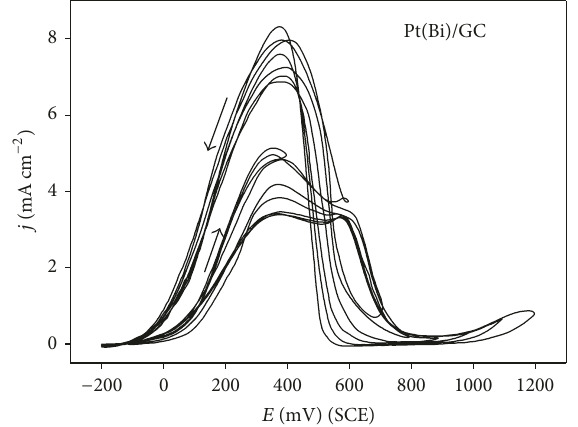
Figure 5: CVs for oxidation of 0.125 M HCOOH in 0.1M H 2 SO 4 on Pt(Bi)/GC electrode at 50mVs – 1 and 𝜛 = 1500 rpm for successive increases of the forward potential scan limit.